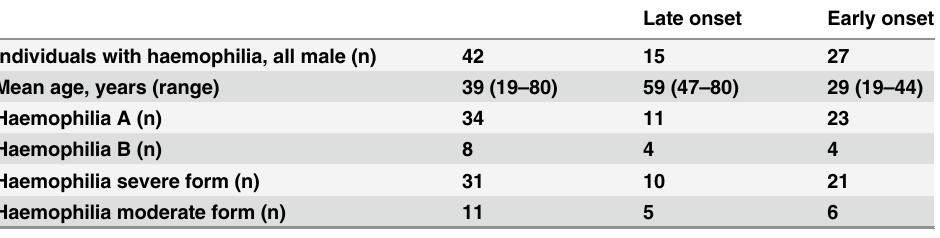
Late onset Early onset